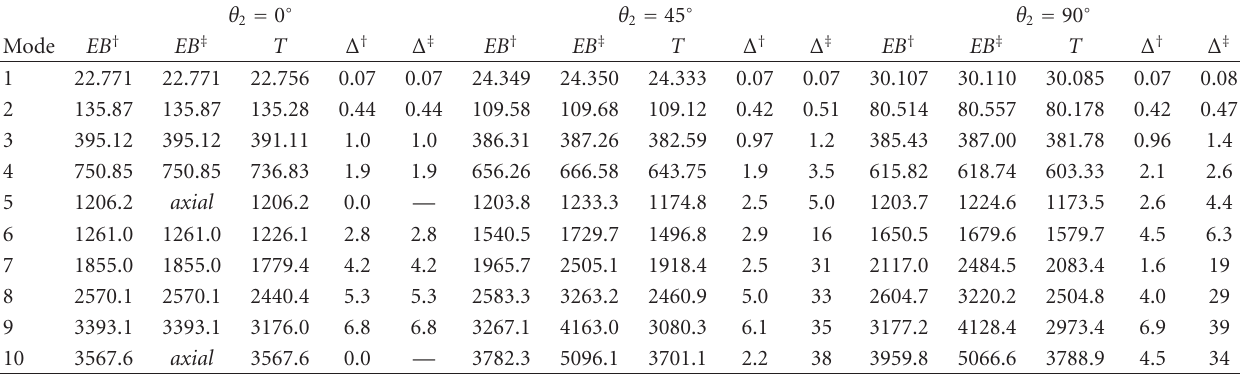
Table 5: First ten natural frequencies (Hz); two-link manipulator; ( L 1 /h = 16 . 67, L T /h = 34 . 67).